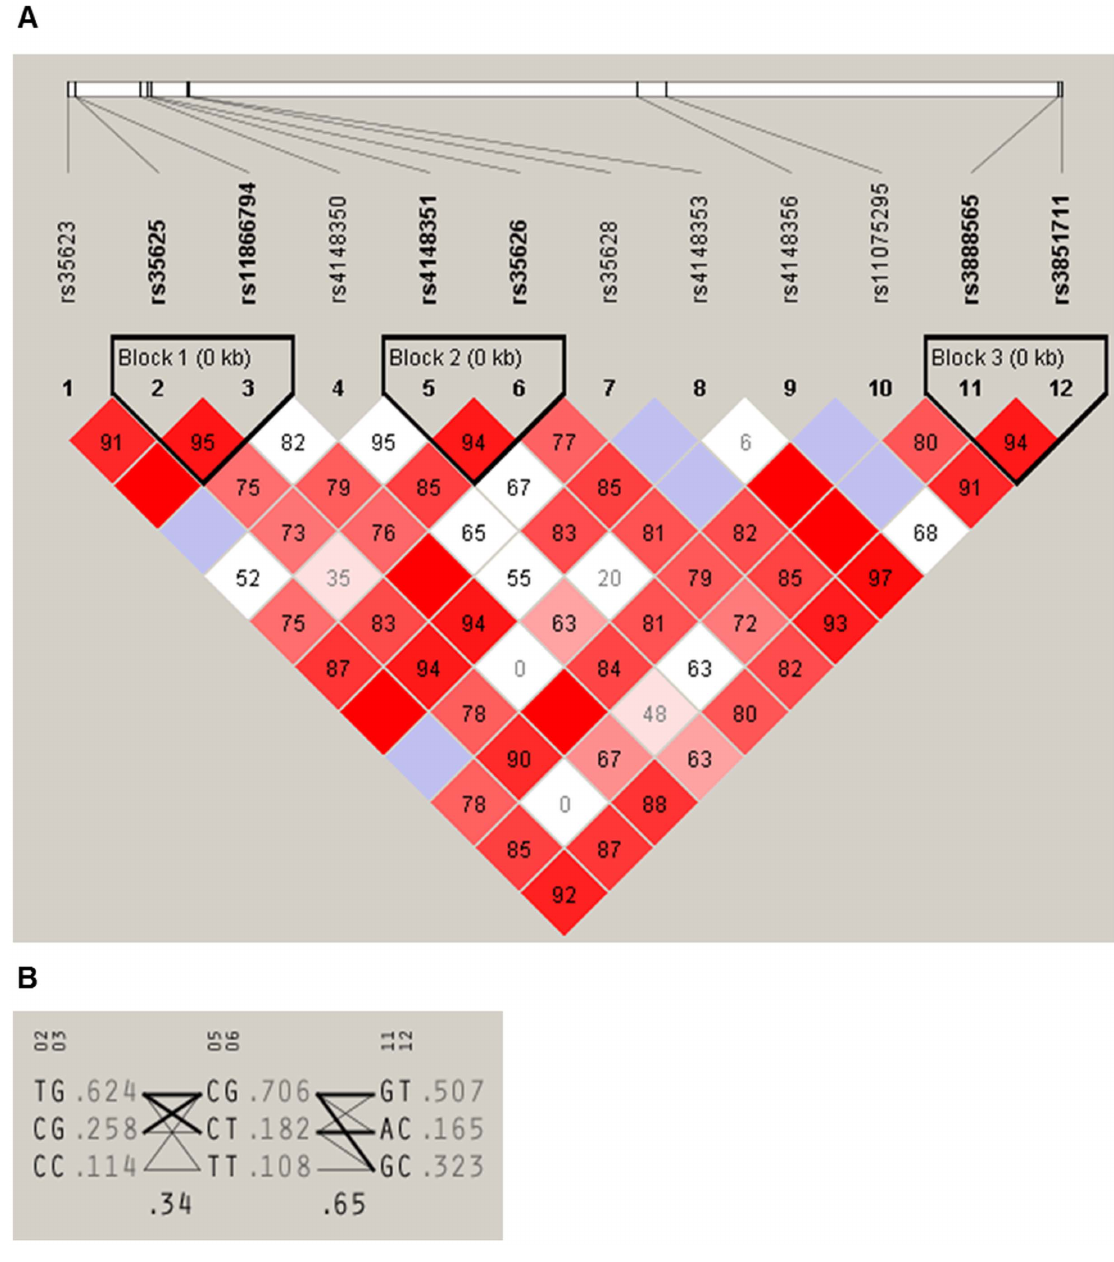
Figure 2. Haplotype analysis of ABCC1 SNPs. Figure indicates linkage disequilibrium plot (A) and three blocks comprising of SNP diplotypes (B) predicted from experimental data obtained in the present study. The likelihood of linkage of two tested SNPs increases from white to red color (A). Population frequency of diplotypes and connections from one diplotype block to the next one are shown (B). Analysis was performed by HaploView v4.2 program.